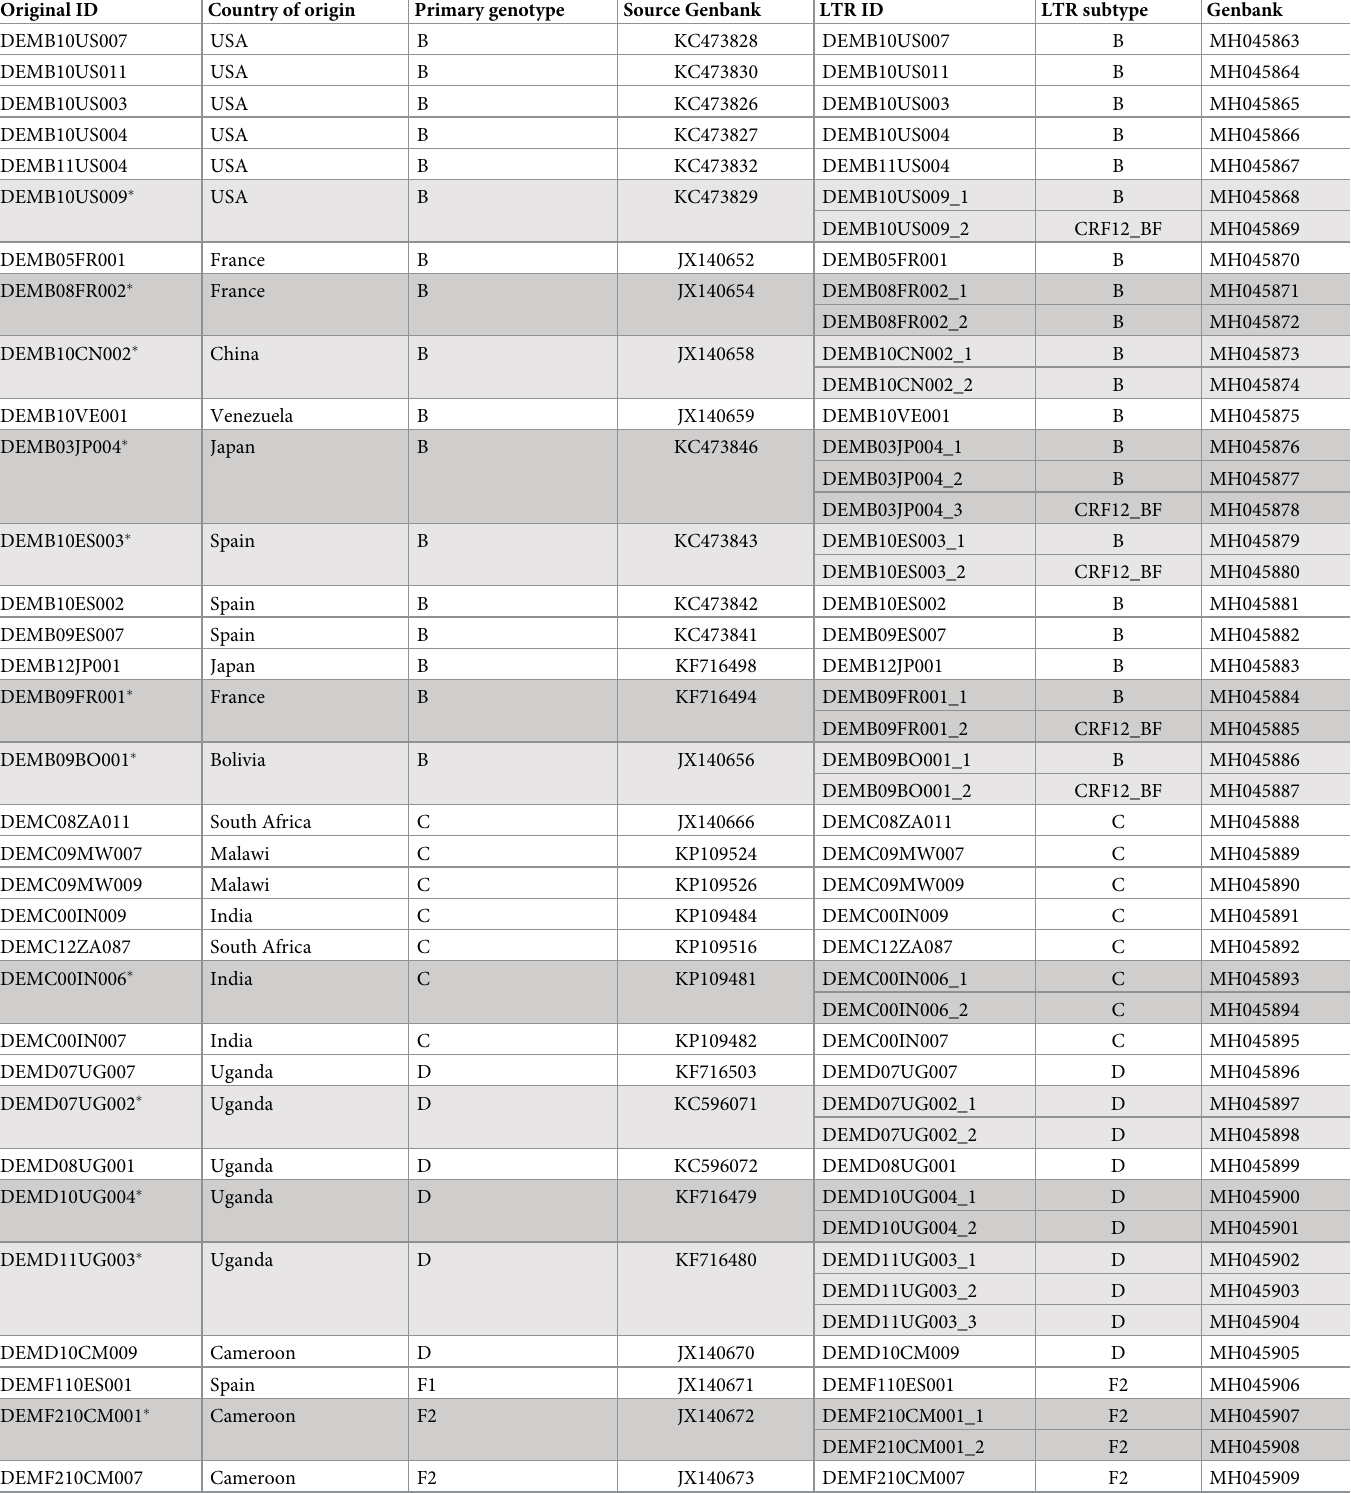
Table 2. Specimens description and LTR subtype